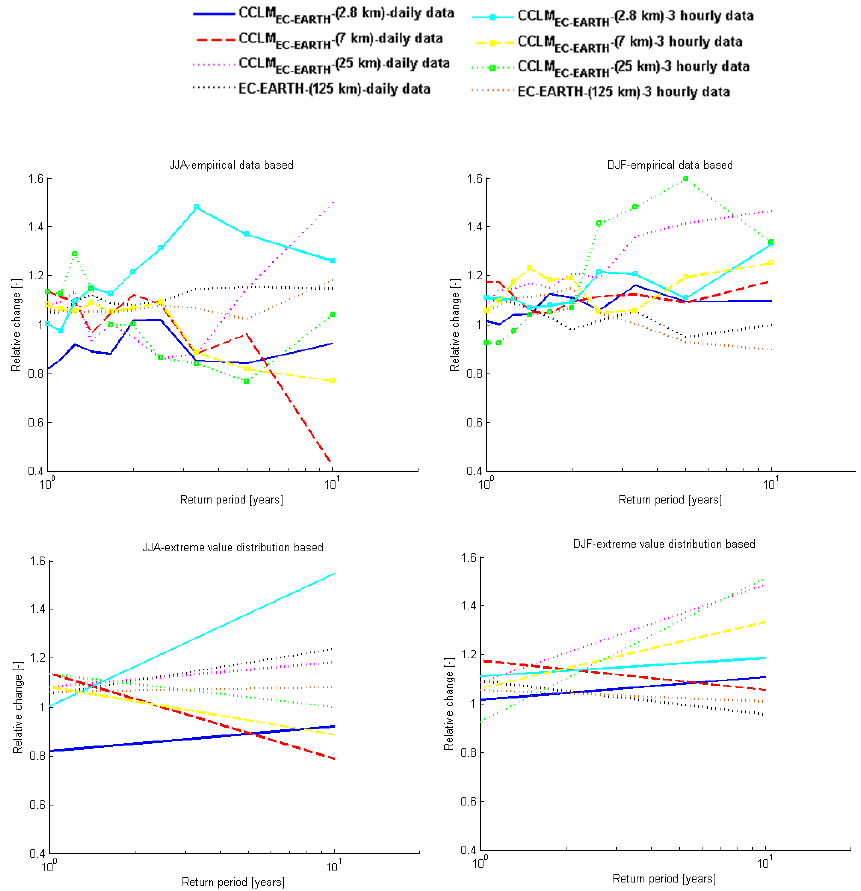
Figure 8. Change factors for daily and 3-hourly precipitation quantiles computed using CCLM EC-EARTH 2.8, 7, and 25km for the summer (left-column panels) and winter (right-column panels) seasons, obtained from the empirical data (top panels) and after use of the extreme value distributions (bottom